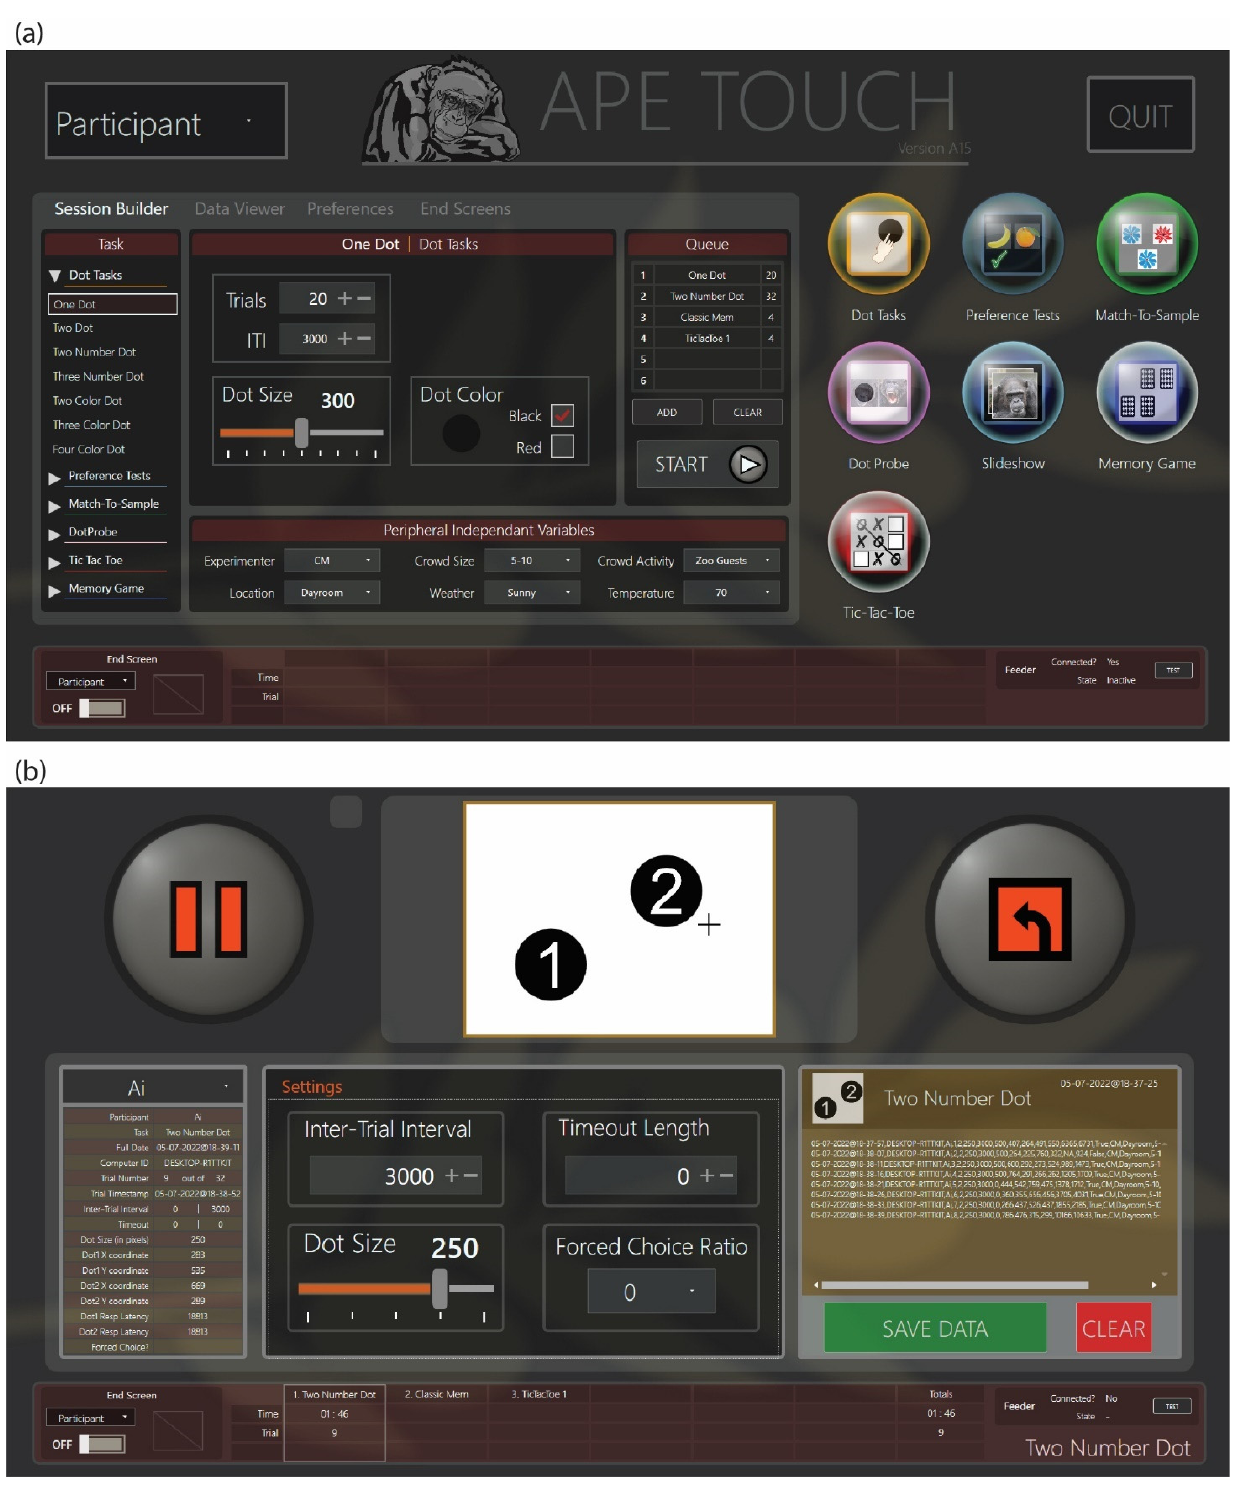
Figure 2. Screenshots of the ApeTouch user interface. ( a ) The main menu screen. On the right side are icons that lead directly to the control screen for each task. On the left are settings, preferences, and data panels as well as the session builder for creating session queues consisting of multiple tasks. ( b ) The control screen for the Two Number Dot task.